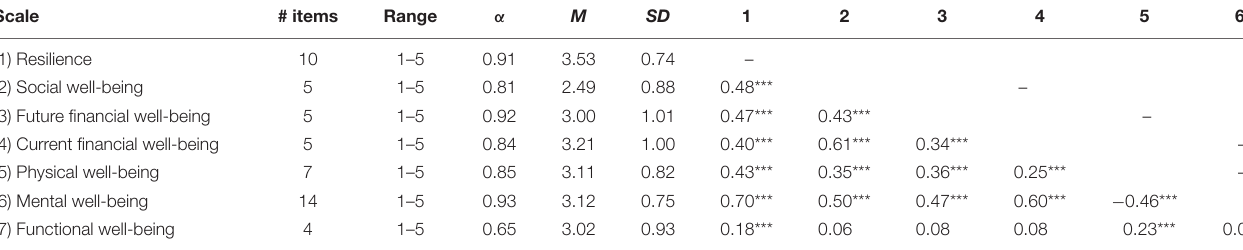
TABLE 2 | Descriptive statistics and Pearson’s correlations for resilience and components of well-being ( N = 459).